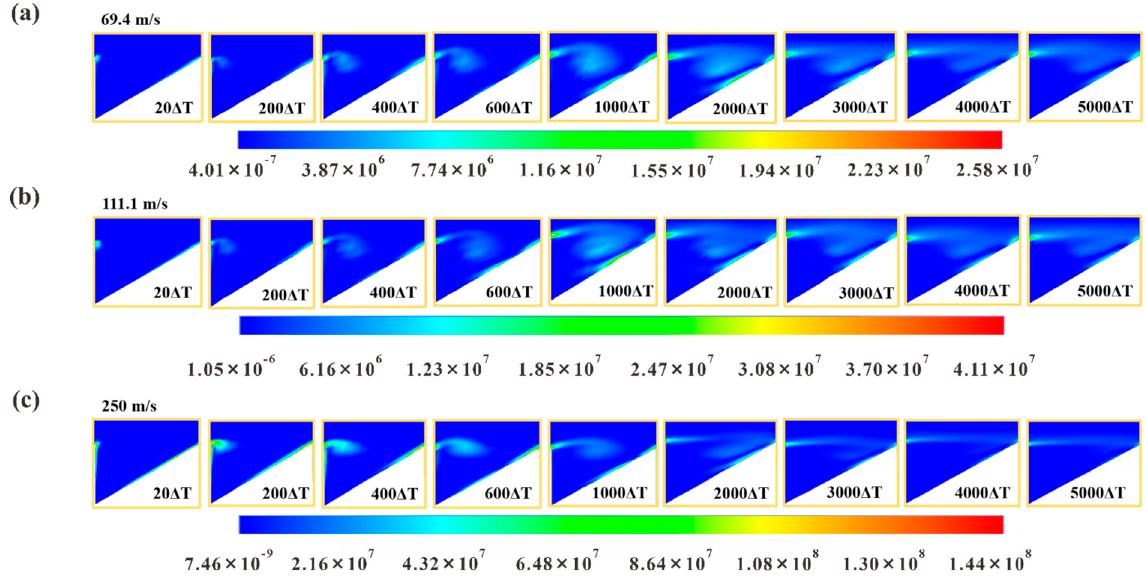
Figure 10. Diagram of vorticity with different velocity under the LES model: ( a ) 69.4 m/s, ( b ) 111.1 m/s and ( c ) 250 m/s.